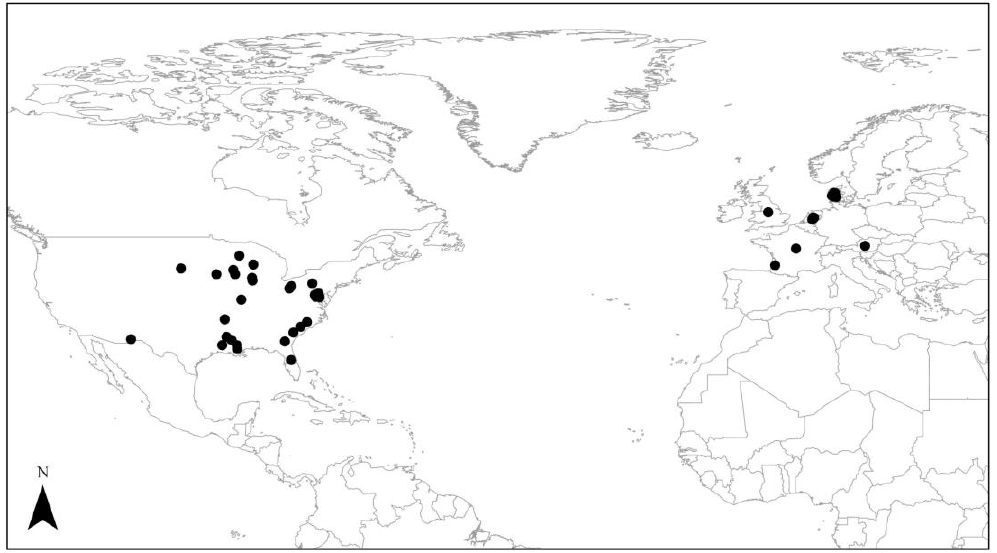
Figure 2. This is a map of the 40 floodplains included in the statistical review. Some reviewed studies included multiple floodplains within one publication. included multiple floodplains within one